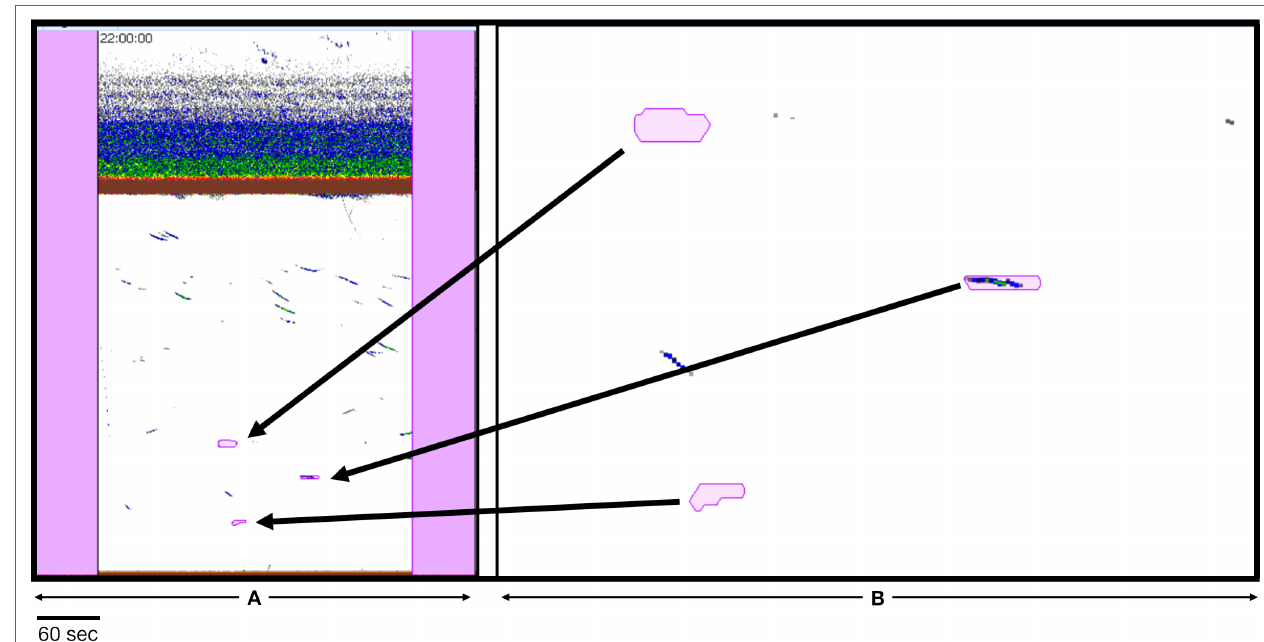
FIGURE 9 | Example of false positive “patch” bad data regions identified by Echofilter. (A) A 5-minute section of echogram with passive data regions (pink rectangles) on either side. (B) Enlargement to show the contents within each patch. Empty patches are false positive. The patch containing color samples within it would be classified as fish by the hydroacoustic analyst. It was likely identified as a bad data region by Echofilter because of its nearly horizontal position. The data on which the models were trained contain occurrences of unidentified interference which appear as horizontal lines. Those were classified as bad data regions by the analyst prior to training. Both models (Bifacing@100ep and Upfacing@100ep) designate true and false positives, but differently. Bifacing@100ep results appear to include fewer false positives. Data: stationary data with echosounder in upfacing orientation, active data recorded for 5 minutes and passive data for one minute at Minas Passage Site.